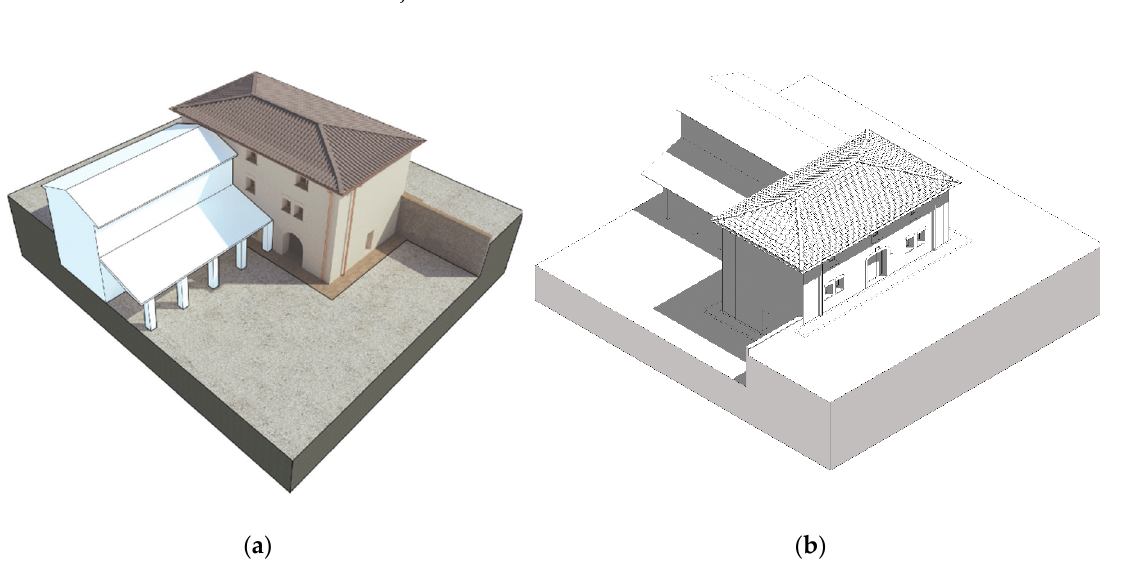
Figure 2. Historical Building Information Modeling (HBIM): ( a ) back rendered view; ( b ) front 3D view.